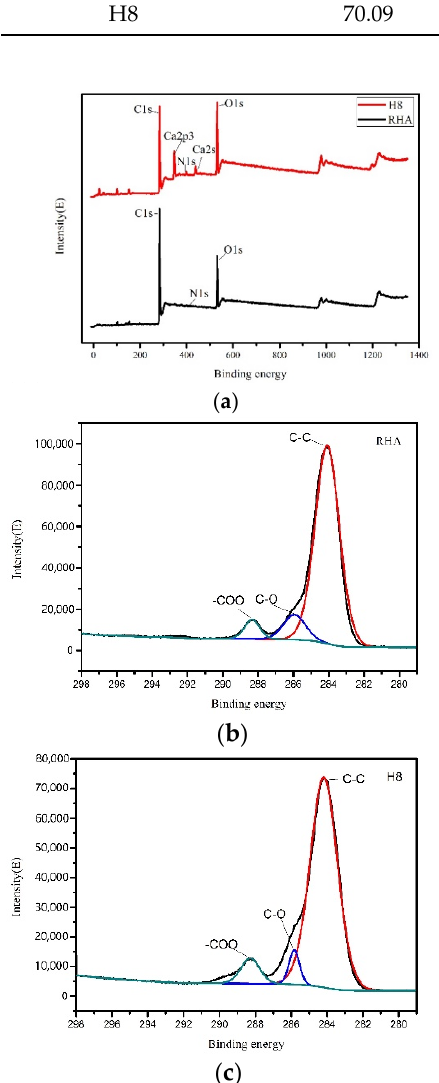
Figure 7. Photoelectron spectroscopy contrast diagram of RHA and H8: ( a ) Photoelectron spectroscopy of RHA and H8; ( b ) XPS fitting peaks of RHA and ( c ) XPS fitting peaks of H8.